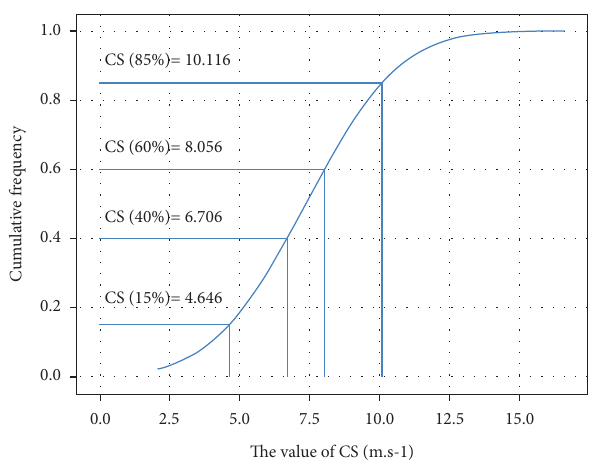
Figure 4: Cumulative frequency curve for the CS.